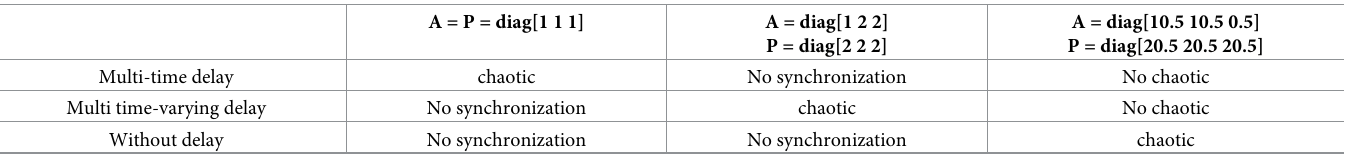
Table 4. The multi-FONNSMD system performance with different values of a parameter.